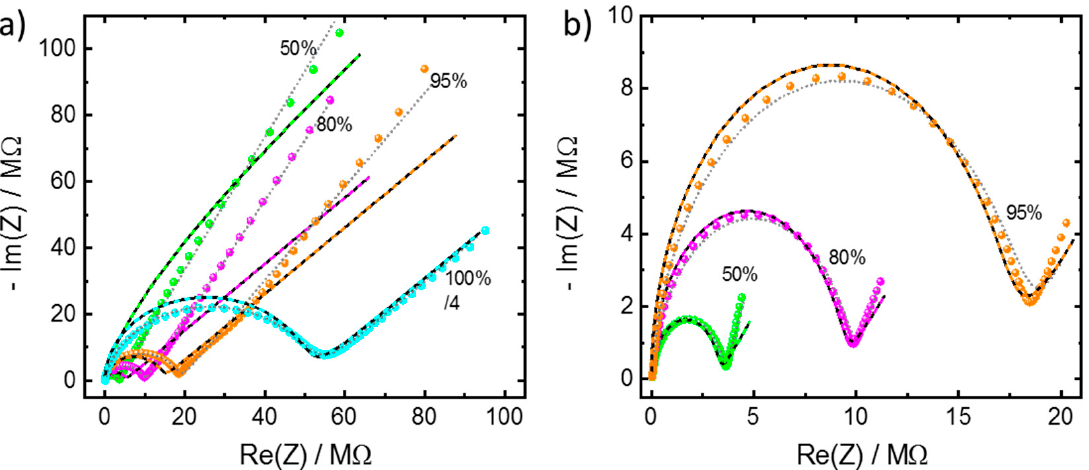
Figure A3. Nyquist plots for the IL@HKUST-1 in the form of a thin film on a glass substrate with interdigitated gold electrodes, see Figure 3c. The experimental data are shown as spheres, the grey-dotted lines are the fits with the ( R- CPE dl ) ‖ CPE geo circuit (same data as in Figure 3c). The black-color-dashed lines are the best fits by Randles equivalent circuit. The IL pore fillings are 50%, 80%, 95%, and 100%, as indicated. The frequency range in panel ( a ) is 0.5 Hz to 5 MHz, and in panel ( b ) is 107 Hz to 5 MHz. Only the plotted data are used for the fitting by the models. Like in Figure A2, the major reason for the poor description of the experimental data by the Randles circuit is the fact that the Warburg resistance of the Randles circuit results in a low-frequency ray with an angle of 45 ◦ in the Nyquist plots, which is often not the case in the experimental data. This results in poor fits, especially when the EIS data at the low-frequency range is recorded—see panel ( a